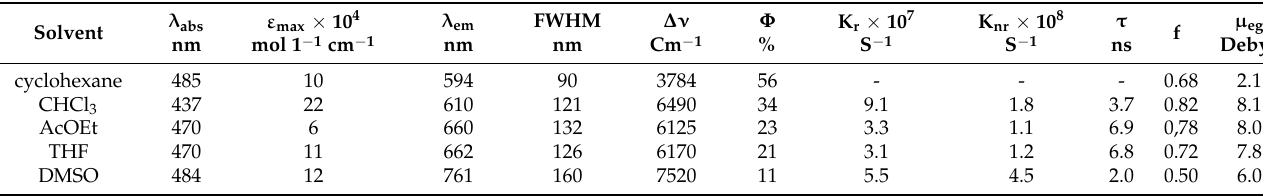
Figure 3. Photoluminescence spectra for investigated compounds 1a ( a ), 1b ( b ), and 1c ( c ) recorded in solutions. Table 3. Photophysical parameters obtained for 1b : absorption maximum wavelength, λ abs ; maximum molar extinction coefficient, ε max ; wavelength of emission maximum, λ em ; full width half maximum, FWHM; Stokes shift, ∆ ν ; quantum yield, Φ ; radiative and non-radiative rate constant, K r and K nr , respectively; fluorescence lifetime, τ ; oscillator strength, f; transition dipole moment, µ eg